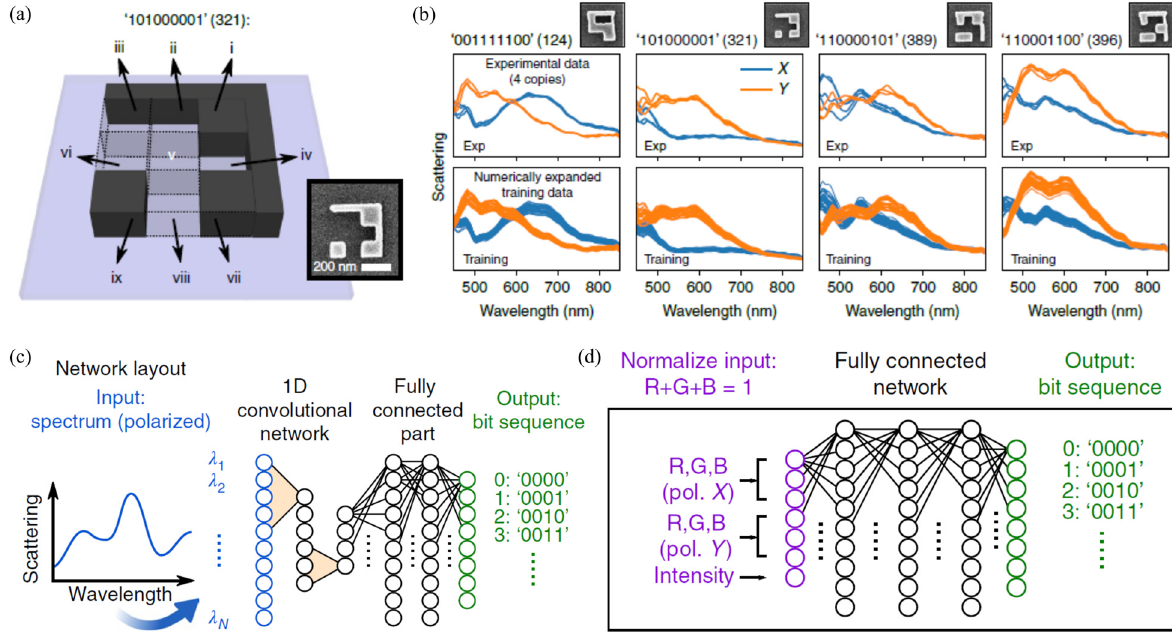
Figure 5: The application of DNN to decode nanophotonic spectral encoded optical information. (a) Geometry of a silicon nanostructure encoding3 × 3=9bits.Eachsiliconblockoccupiesanareaof105 × 105nm 2